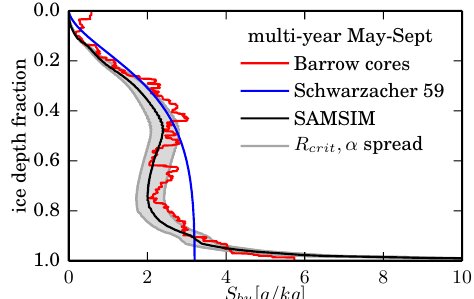
Figure 11. May to September mean of vertically normalized multi- year salinity profiles of reanalysis forced simulations using the com- plex brine dynamic parametrizations. Schwarzacher 59 refers to the fitted profile of Schwarzacher (1959), and Barrow cores refers to the multiyear ice cores taken by the Alaska Ocean Observing Sys- tem from 1999 to 2011 (Eicken et al., 2012). The R crit ,α spread shows the SAMSIM profile using the two non-default values of the gravity drainage parameters obtained from the optimization process (see Sect. 2.2). Left line: α = 0 . 000681 ,R crit = 3 . 23. Right line: α = 0 . 000510 ,R crit = 7 . 10. The area between the two simulations is shaded in light